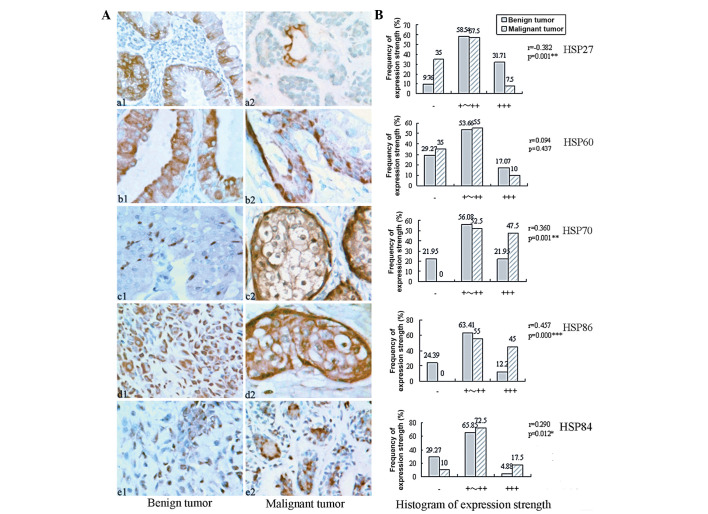
Expression location and strength of 5 HSPs in salivary gland tumors. (A) Expression location and strength of 5 HSPs (IHC-SP staining; magnification, ×400). HSP27 and HSP60 were located in the cytoplasm of the tumor epithelium, but in adenolymphoma they were mainly expressed in (a1) the lower epithelium and (b1) the top epithelium, respectively. HSP70 was significantly expressed in the nucleus and cytoplasm, but (d) HSP86 and (e) HSP84 were mainly located in the cytoplasm and partly expressed in nucleus. Expression of HSP27 was less in (a2) malignant tumor compared with (a1) benign tumor, but (c2) HSP70, (d2) HSP86 and (e2) HSP84 were all stronger in malignant tumor compared with (c1, d1 and e1) benign tumor. (B) Histograms of expression strength of the 5 HSPs. *P<0.05; **P<0.01; malignant tumor (group) vs. benign tumor (group). ***P<0.001. HSPs, heat shock proteins.